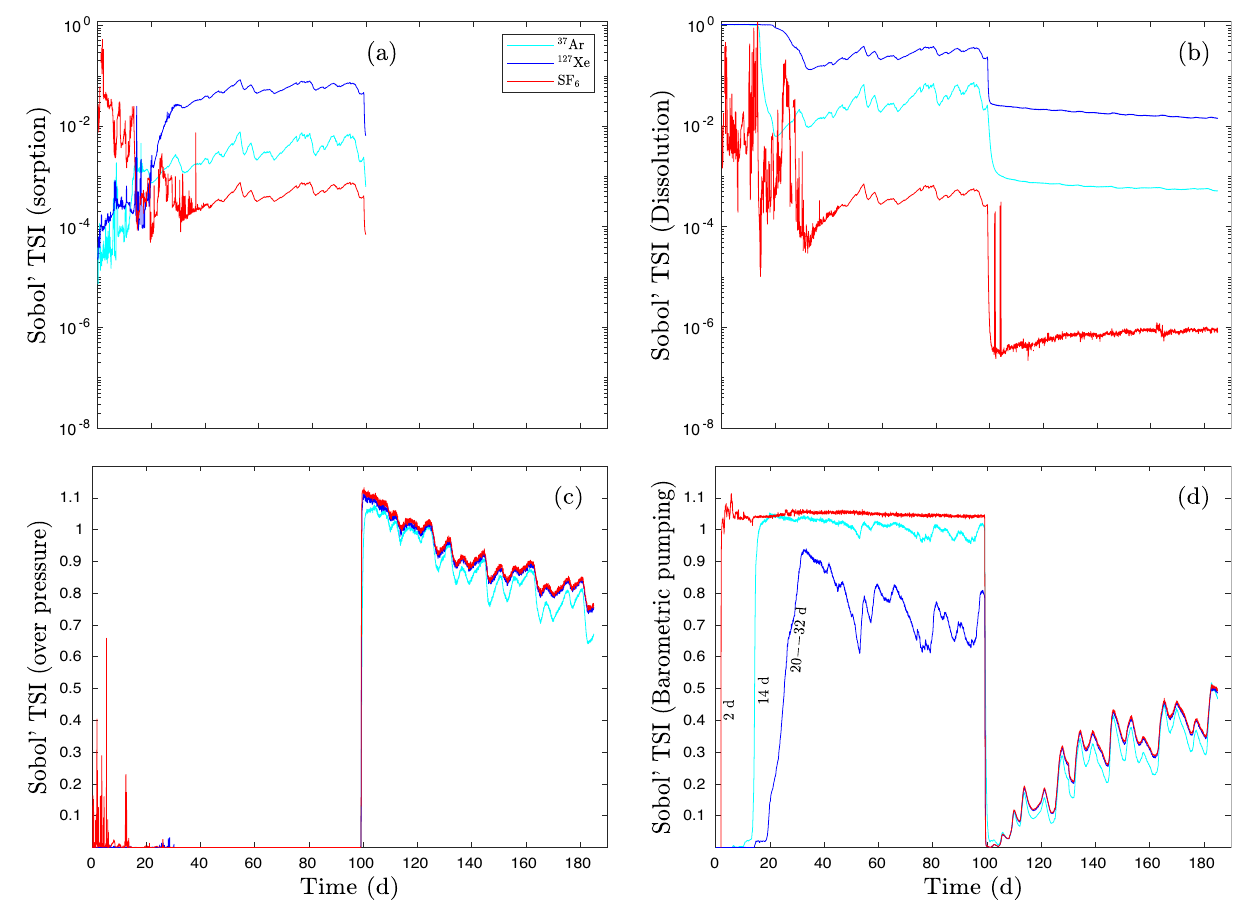
37 127 Ar, Xe, and SF 6 signals at ground surface of the Barnwell system.